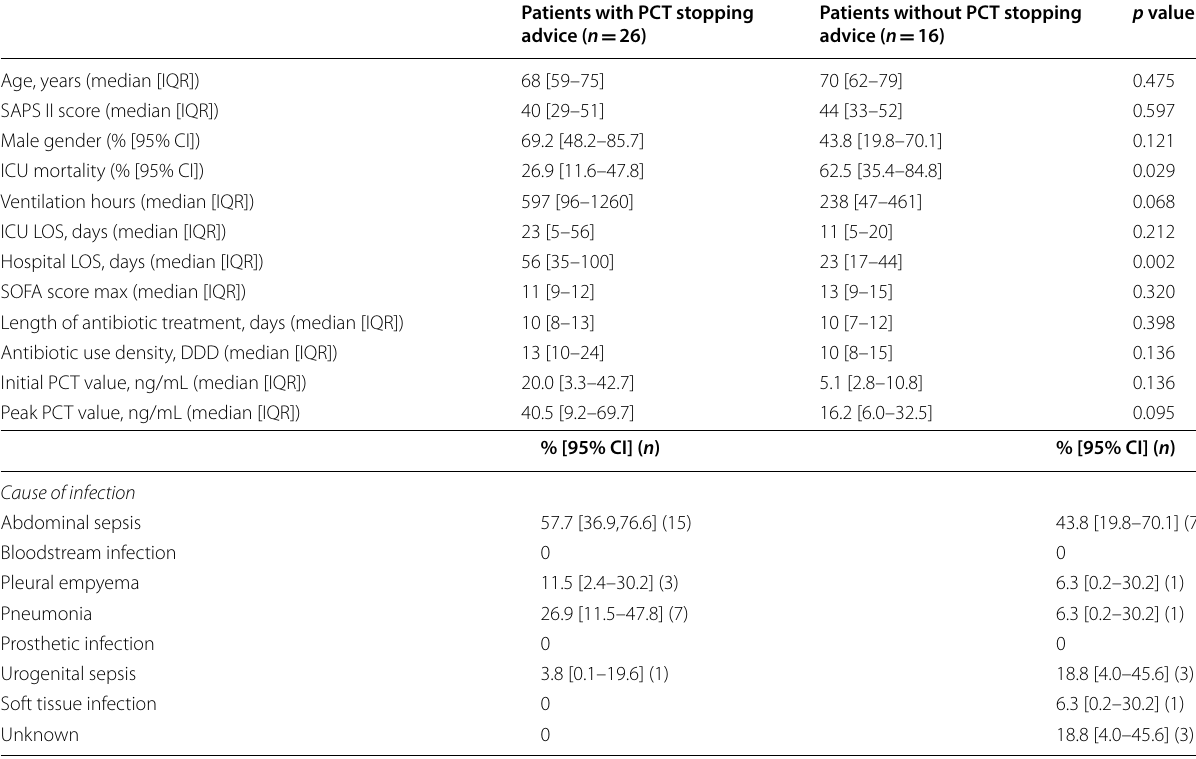
Table 2 Demographics and clinical data of patients with and without procalcitonin (PCT) stopping advice